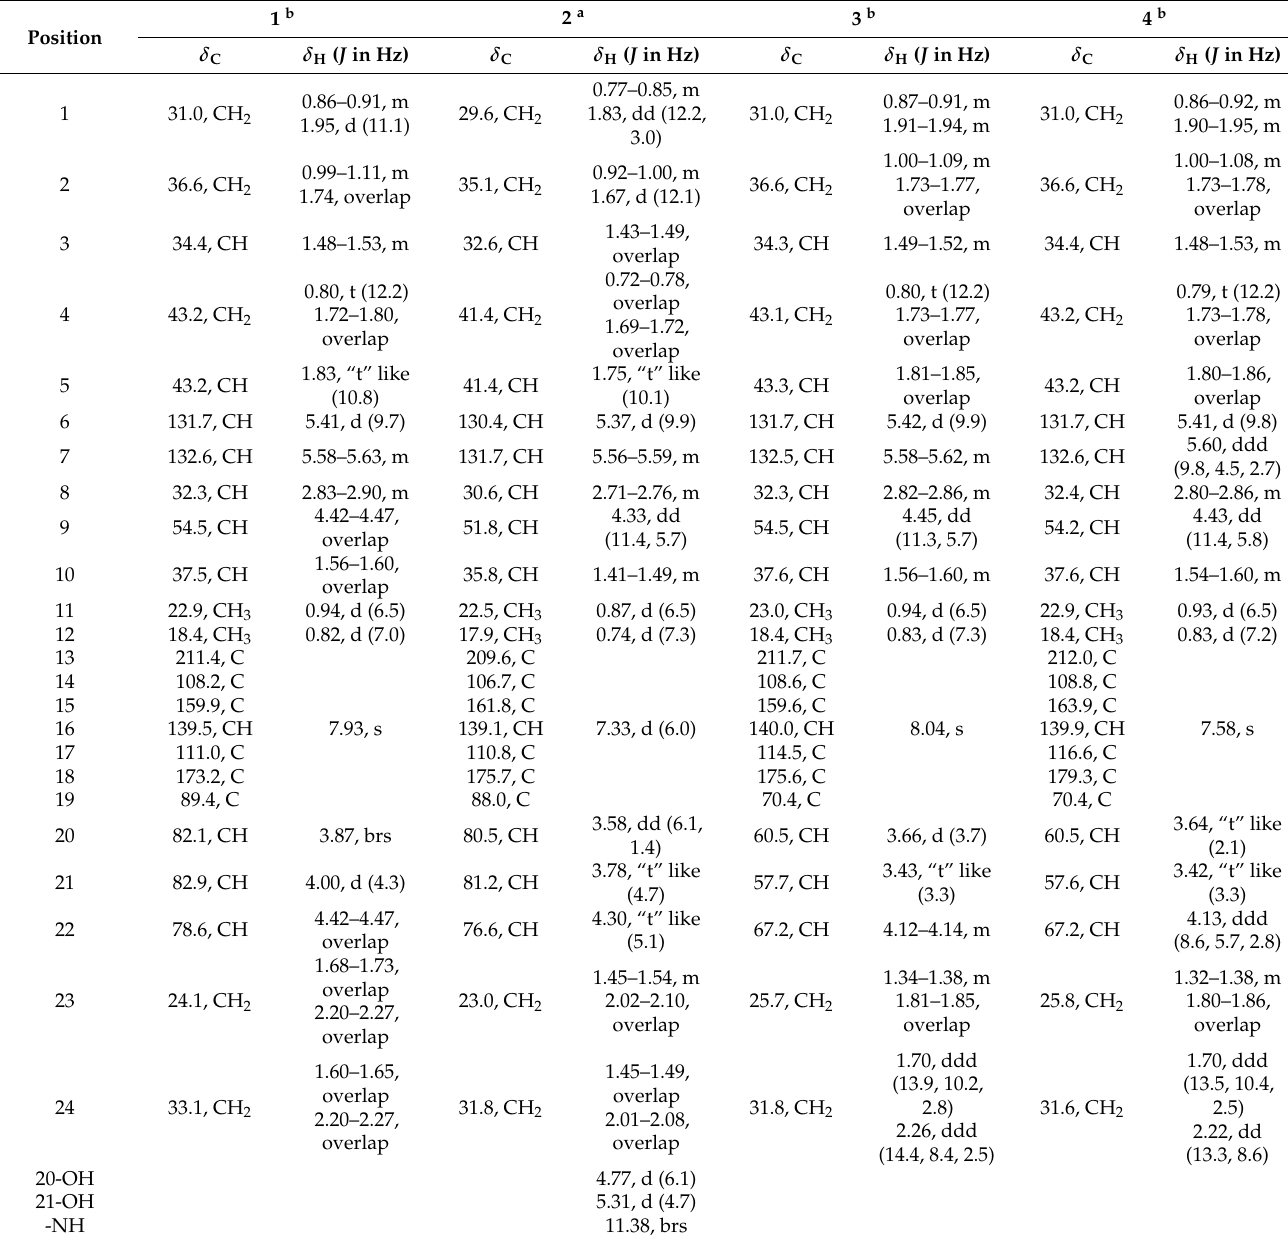
results of the X-ray (Figure 3) analysis (Flack parameter = − 0.15 (11), CCDC: 2218951) confirmed an oxygen bridge between C-19 and C-22 forming the furan ring and led to the final determination of its absolute configuration as 3 R , 5 S , 8 R , 9 R , 10 R , 19 S , 20 S , 21 S , 22 S . This novel 4-hydroxy-2-pyridone was named furanpydone A. Table 1. 1 H (600 MHz) and 13 C (150 MHz) NMR data of 1 – 4